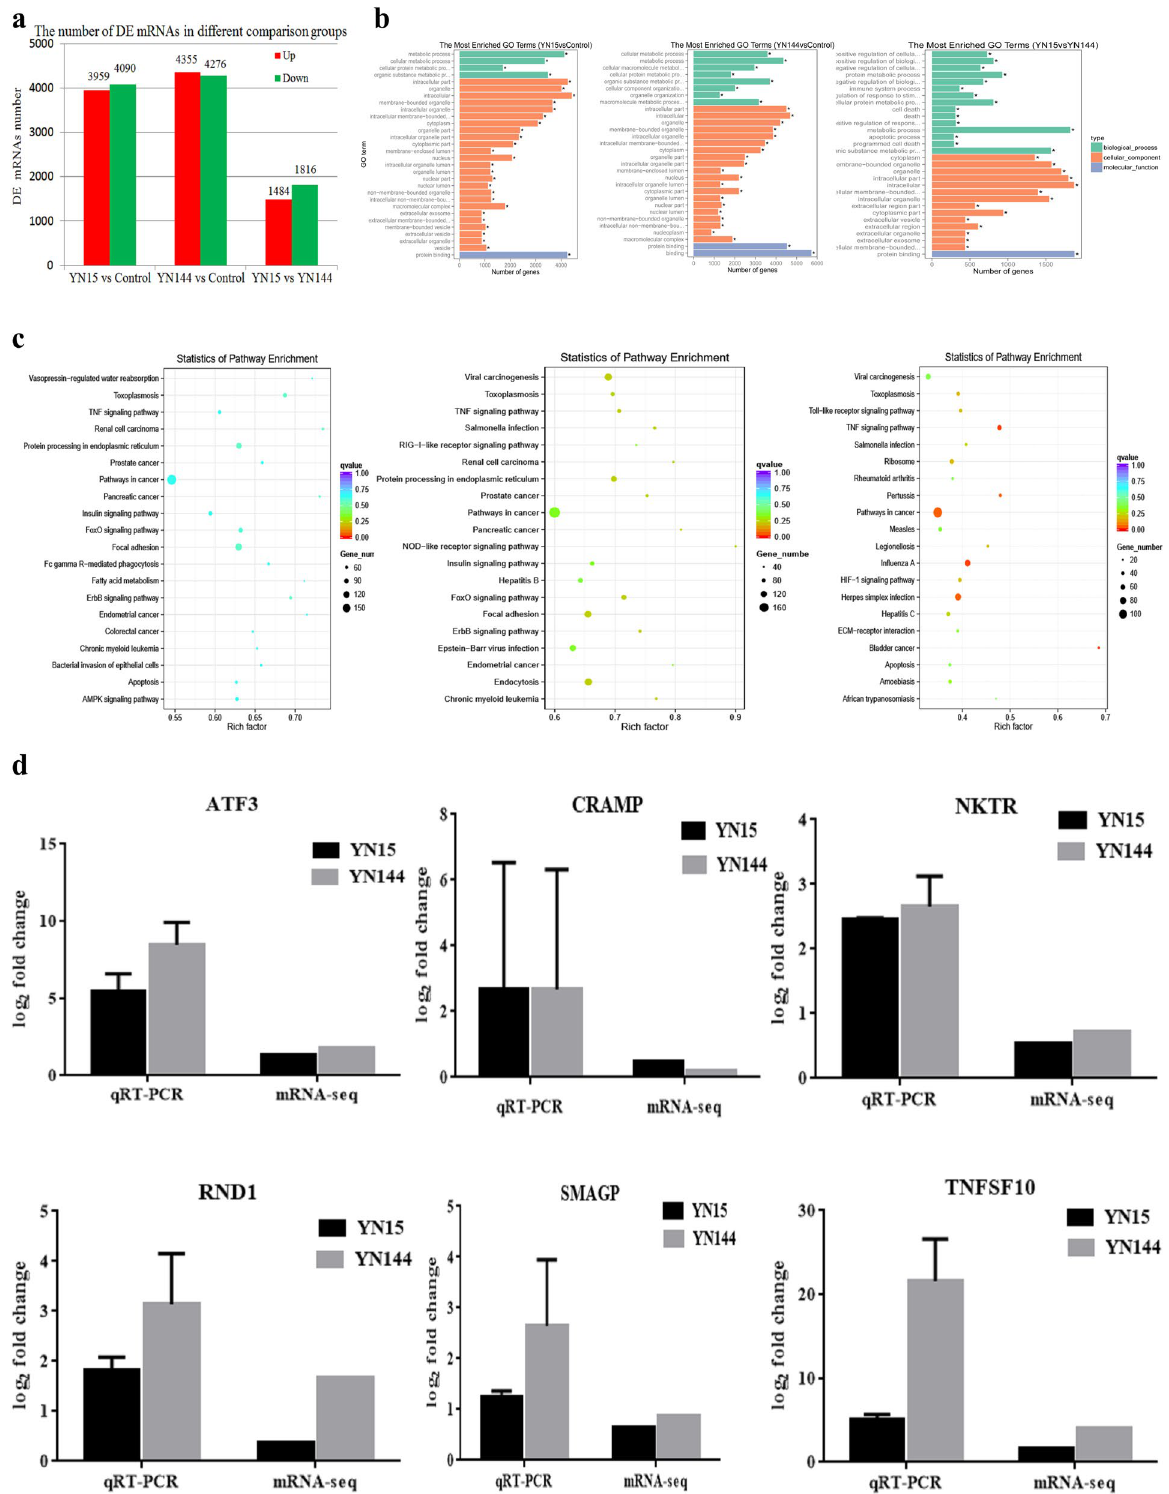
Figure 2. mRNAs expression profiles in PEDV-infected ST cells. ( a ) The bar graph shows the number of DE mRNAs in each one of the three comparison groups, red represents the amount of up-regulated DE mRNAs, green represents the count of down-regulated DE mRNAs ( p -value < 0.05). ( b ) GO analysis of the DE mRNAs in PEDV infection ST. The three panels show the GO enrichment analysis of each of the top 30 significantly most DE mRNAs from the three comparison groups (YN15 vs Control, YN144 vs Control, and YN15 vs YN144), respectively. ( c ) KEGG analysis of the DE mRNAs in ST cells infected with PEDV. The three panels show the KEGG enrichment analysis of each of the top 20 significantly most DE mRNAs between YN15, YN144 and control groups, respectively. ( d ) Results of relative quantitative real-time reverse transcription polymerase chain reaction (qRT-PCR) analysis (alongside RNA-seq analysis) of ATF3, CRAMP, NKTR, RND1, SMAGP and TNFSF10 in YN15- and YN144-infected ST cells, respectively. The relative expression of each mRNA was calculated using the 2 -ΔΔCt method. The data are presented as mean ± SEM from three independent